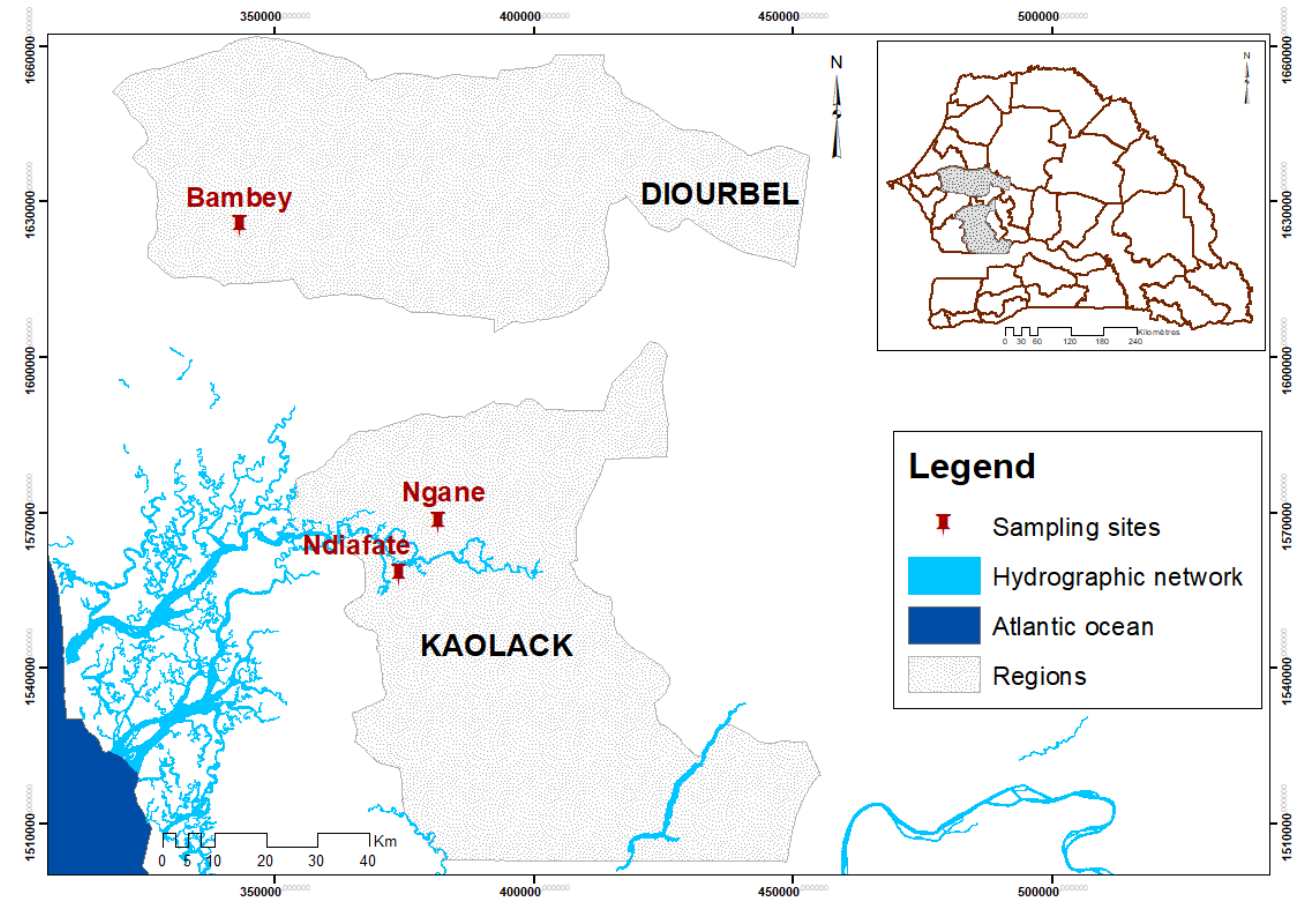
Figure 1. Location of the sampling sites in Senegal. Soil and root samples (containing a mixture of endogen AMF spores, hyphae, and mycorrhized roots) used as inoculum were collected at a depth of approximately 0–20 cm from the A. seyal rhizosphere. Thirty samples were collected randomly at each site.